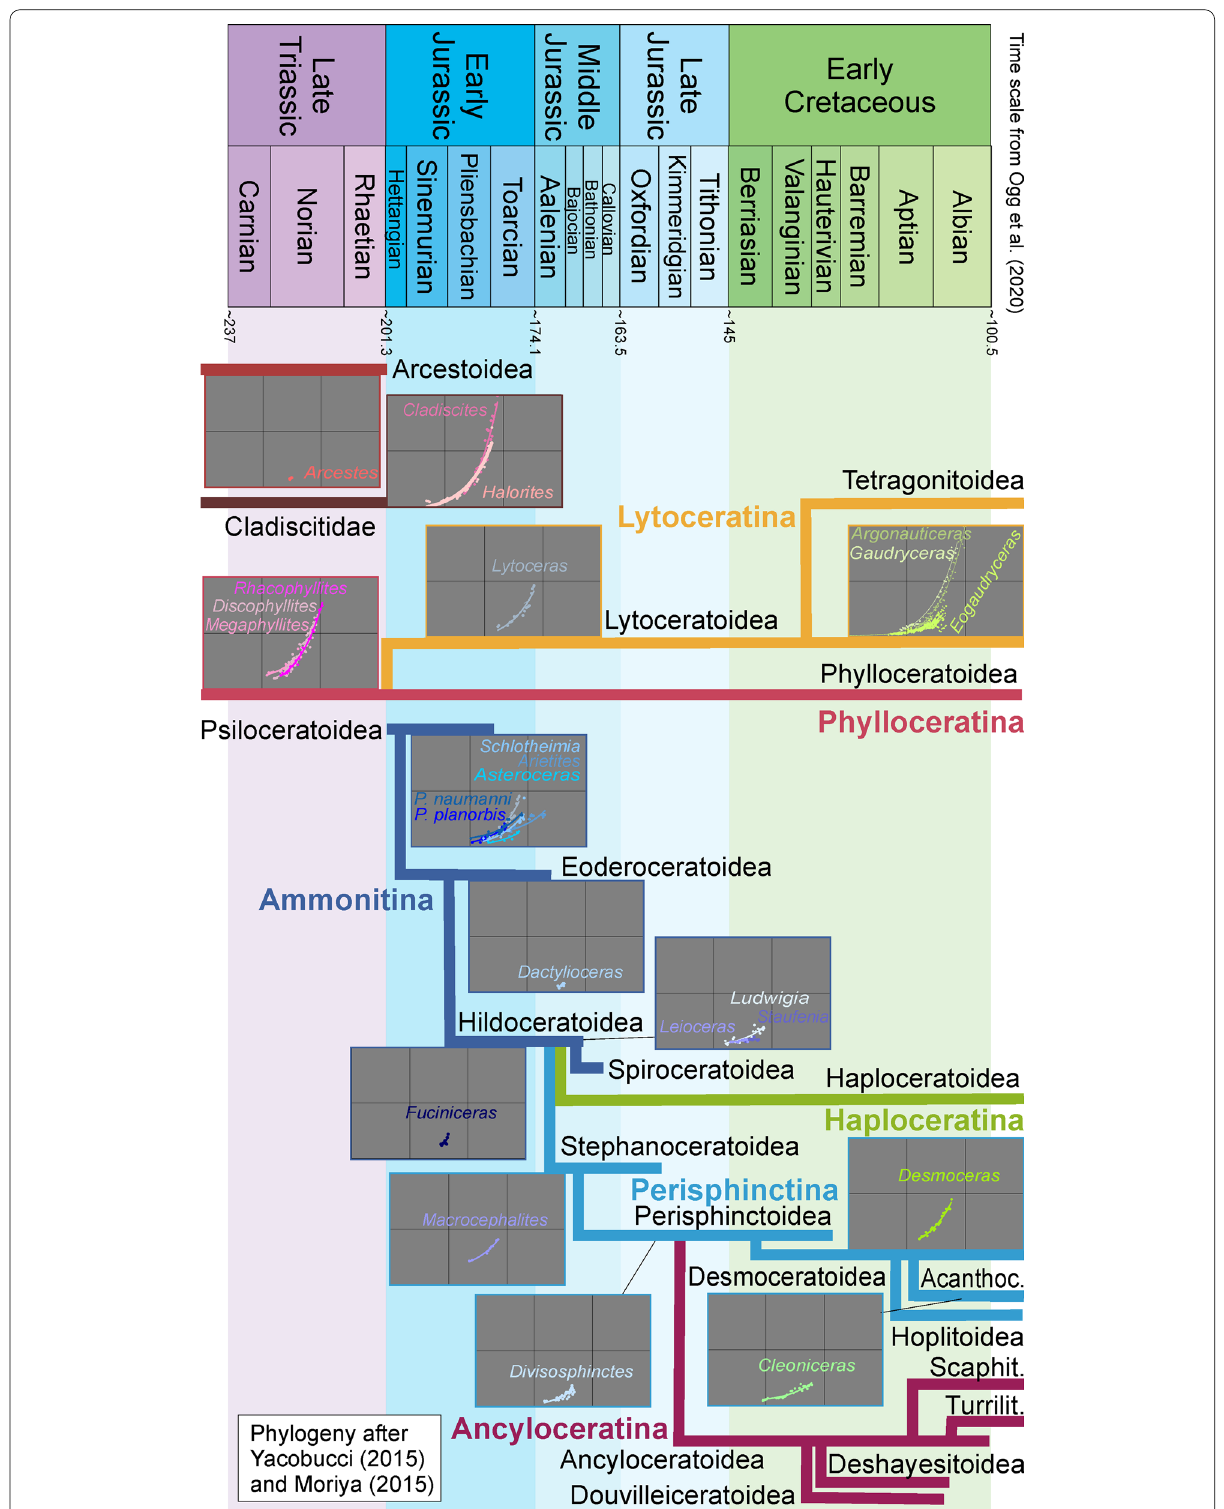
Fig. 11 Ranges of Mesozoic ammonoid (super-)families. Possible evolutionary relationships modified after Moriya (2015) and Yacobucci (2015). Septal slope factor diagrams after Fig.